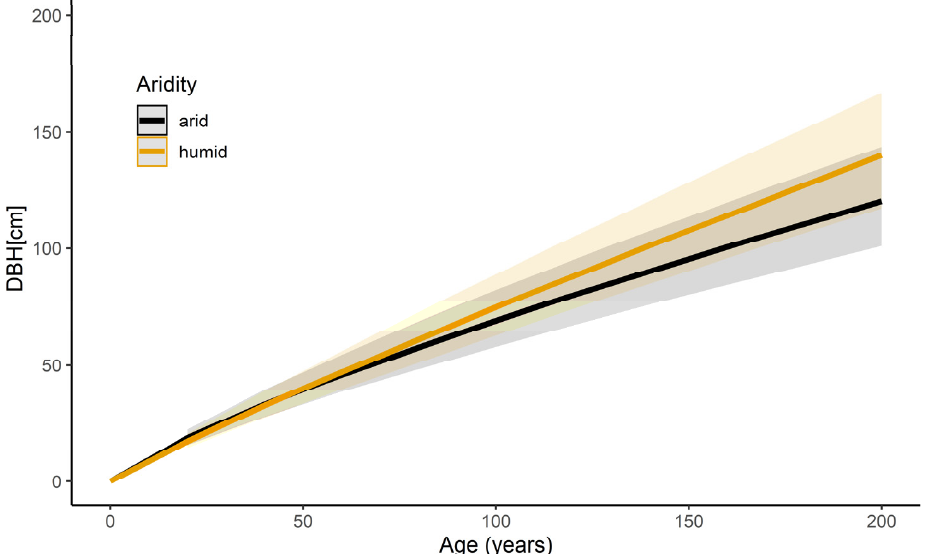
Figure 2. Long-term stem diameter growth reaction of all trees within this study (N = 1178) in dependence on tree age and DMI aridity index based on Equation (2) (see Table A1 for model parameters). The black curve visualizes the stem diameter growth under arid climatic conditions (DMI = 11, corresponding to the 2.5th quantile of annual DMI of all cities). The yellow curve visualizes the diameter growth under humid climatic conditions (DMI = 64, corresponding to the 97.5th quantile of annual DMI of all cities). Shaded bands visualize the predicted confidence interval of the curves.